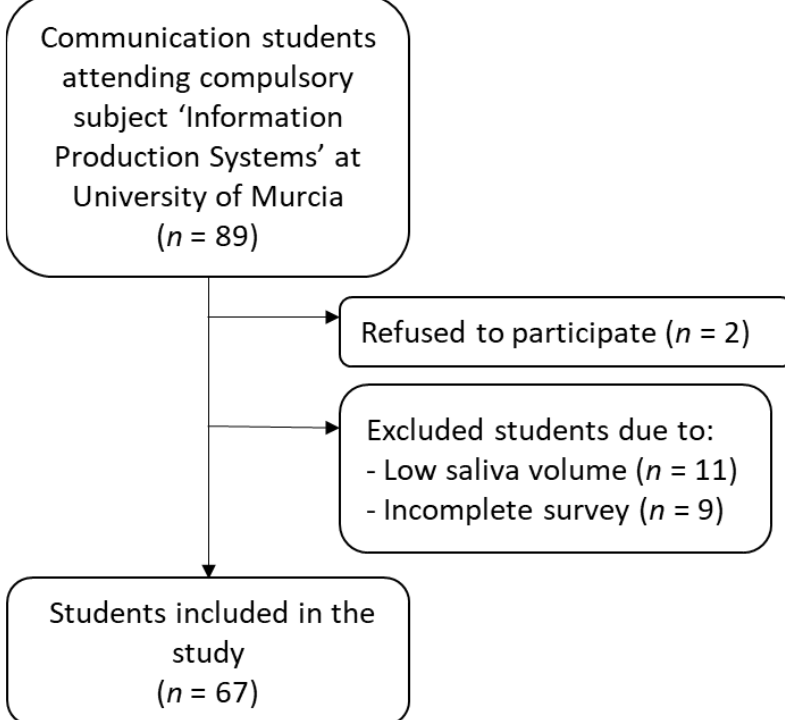
Figure 1. The flow chart of sample inclusion and exclusion.